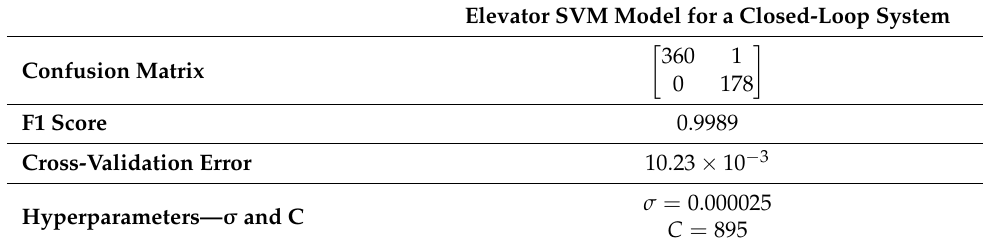
Table 9. Closed-loop elevator SVM model results with tuned hyperparameters.